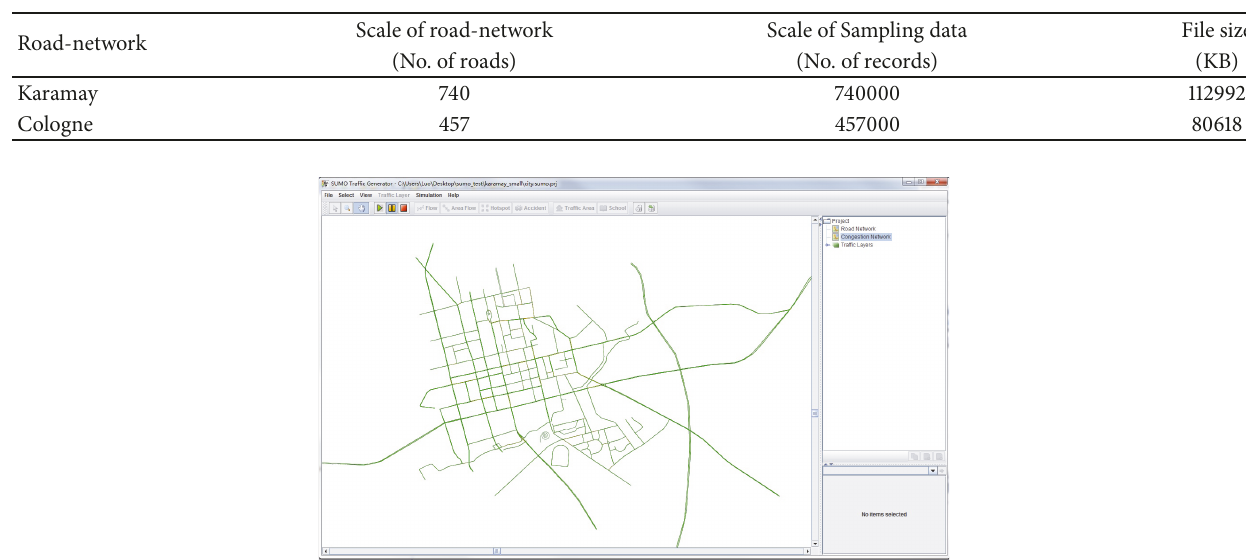
Table 10: Data for performance evaluation for CRO algorithm.